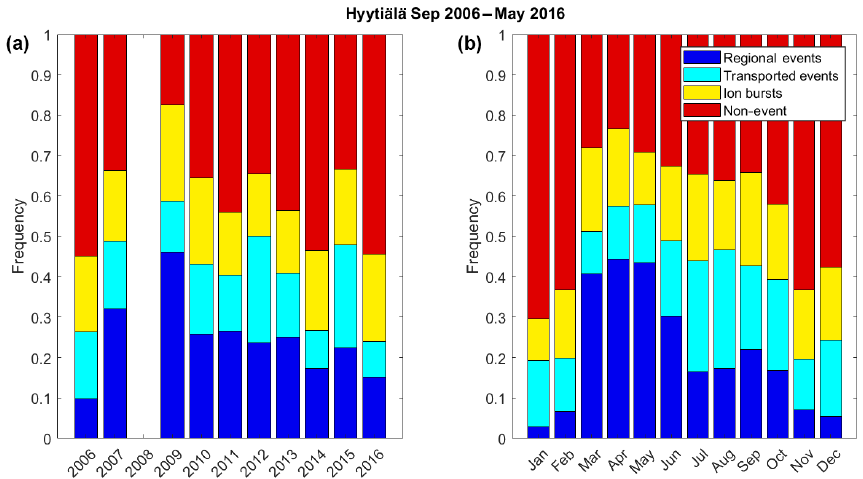
Figure 4. (a) Yearly and (b) monthly fraction of days classified as regional events (REs), transported events (TEs), ion bursts (IBs) and non-events (NEs) using the new classification method. The data from 2009 are biased towards spring months, which could explain the much higher number of events. No data were available during